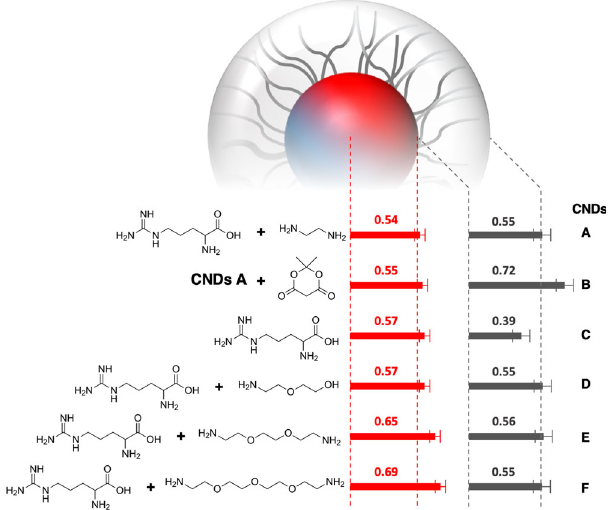
Fig. 5 Core – shell structure of CNDs A – F as obtained from model- fi ts of SAXS patterns. For better comparison, the dotted lines represent the dimensions of the reference species (CNDs A ), which correspond to CNDs after 180 s microwave reaction with fi ltration and dialysis work up. Error- bars denote the mean fi tting uncertainty over all data sets, which is (in relative terms)